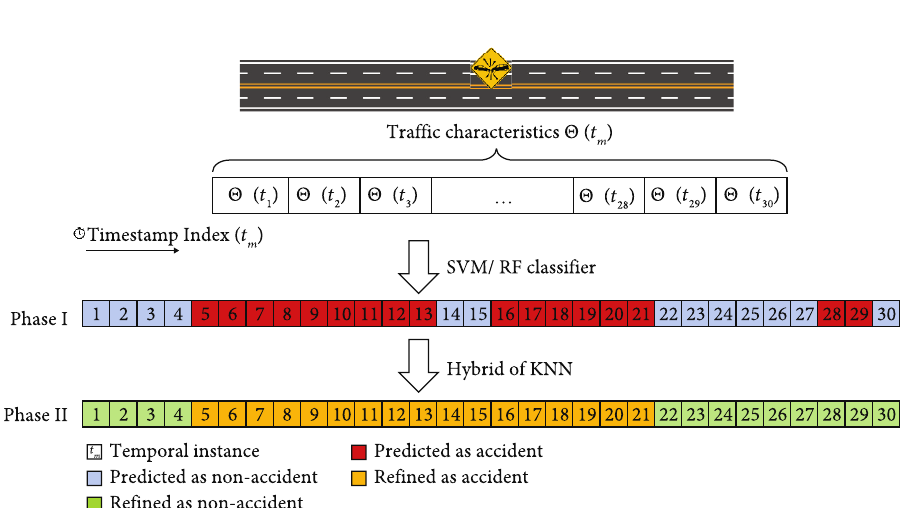
Figure 1: Hybrid learning method overview.